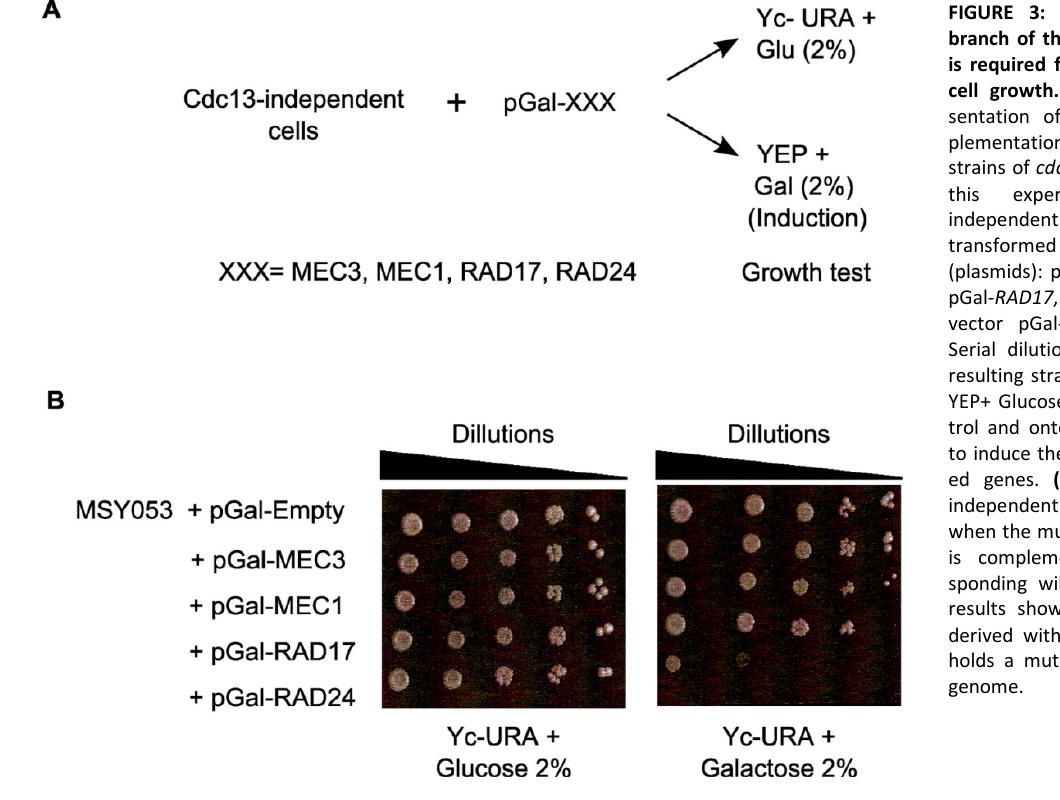
FIGURE 3: An abrogated Mec1- branch of the checkpoint